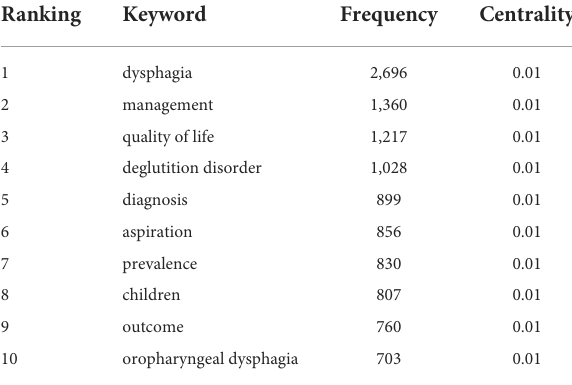
TABLE 7 The top ten keywords and centrality in the research field of dysphagia from 2012 to 2022.